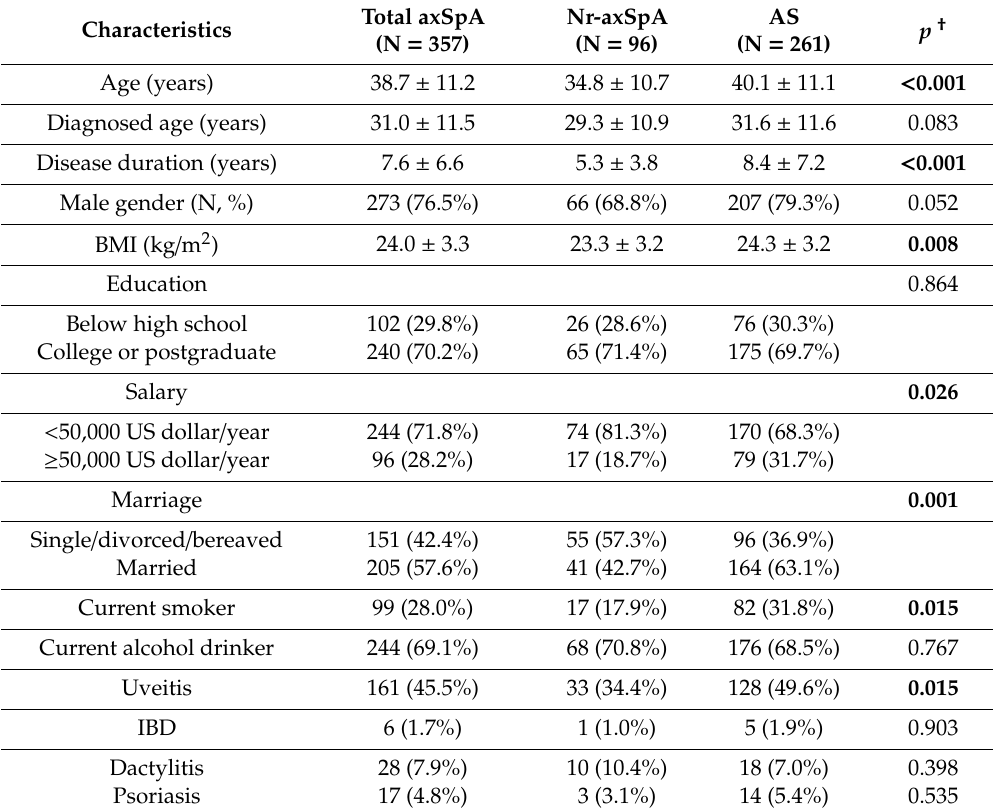
Table 1. Baseline demographic characteristics and comparison between nonradiographic axial SpA (nr-axSpA) and